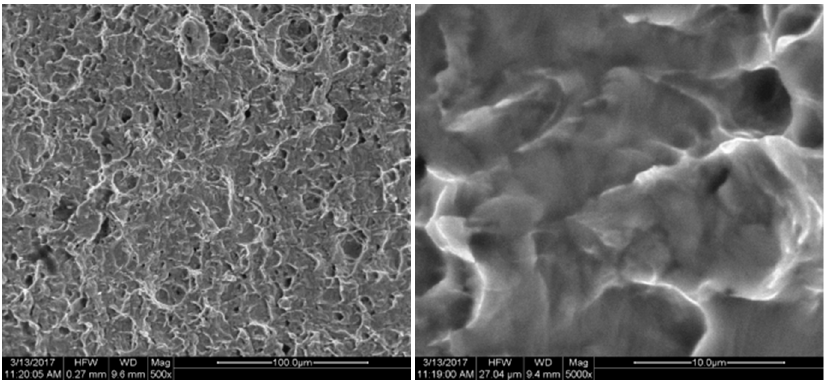
Figure 19. X-axis fracture under the tension speed of 100 μ m/min.